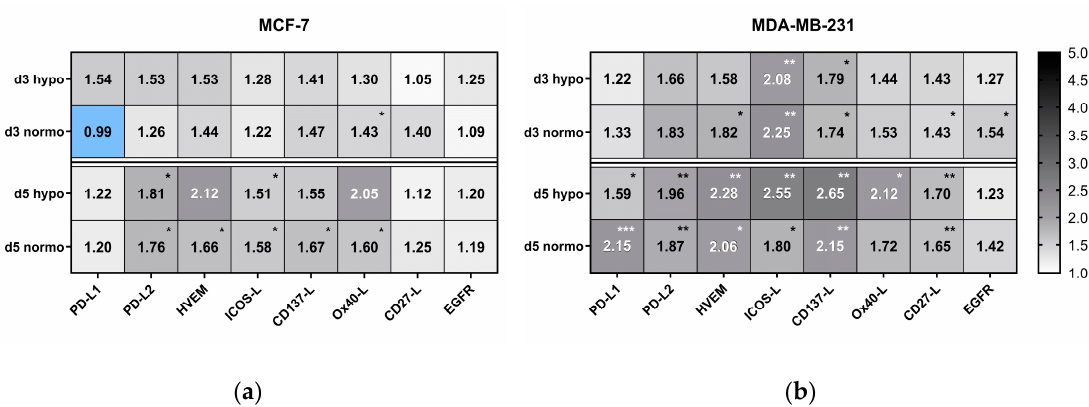
Figure 8. Heatmap of normalized expression (change in mean fluorescence intensity compared to mock-treated cells) of immune checkpoint molecules and of EGFR on day 3 (d3) and day 5 (d5) on the cell surface of ( a ) MCF-7 and ( b ) MDA-MB-231 breast cancer cells after normo- and hypofractionated radiotherapy. Significance test was conducted using Kruskal-Wallis test with uncorrected Dunn´s multiple comparison from three independent experiments, each measured in duplicates * ( p < 0.1), ** ( p < 0.01), *** ( p < 0.001).